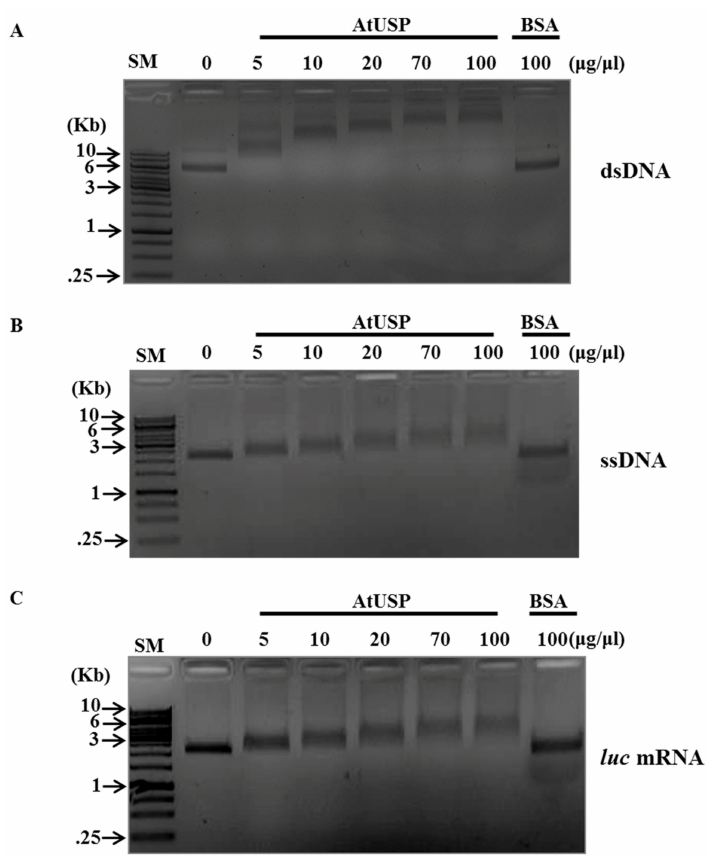
Figure 4. Nucleic acid-binding activity of AtUSP in vitro. Indicated amounts of purified recombinant AtUSP protein were incubated with either ( A ) M13mp8 ssDNA, ( B ) M13mp8 dsDNA, or ( C ) in vitro transcribed luciferase ( luc ) mRNA. To analyze the effect of AtUSP in RNA mobility and the AtUSP-RNA complexes, 0.8% agarose gels were used for gel-shift assays. Bovine serum albumin (BSA) protein (100 µ g/ µ L) was used as a negative control. SM presents size marker from Thermo Scientific